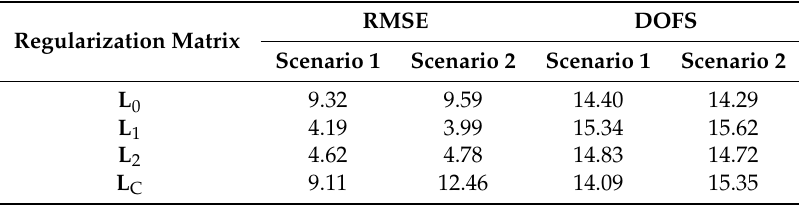
Figure 2. Comparison of temperature retrievals for case 2. Retrieved temperature profiles are shown for the four regularization matrices. The left and right panels correspond to two scenarios using different true profiles. Table 3. Root mean square error (RMSE) and DOFS for case